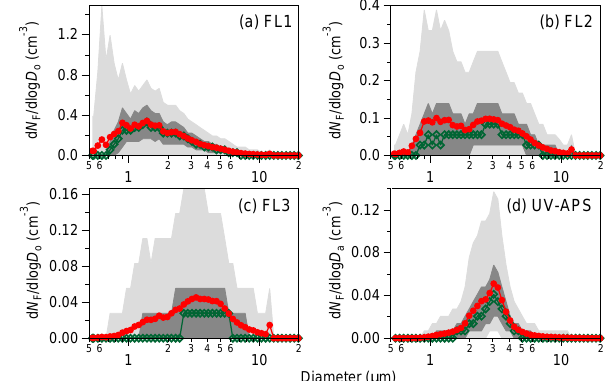
Figure 3. Average FBAP number size distributions measured by WIBS-4 for (a) FL1, (b) FL2, (c) FL3, and (d) UV-APS for the entire sampling period. Red traces show mean values, green traces show median, dark-gray areas show 25–75th percentile, and light- gray areas show 5–95th percentiles. Vertical scale is different in each panel.